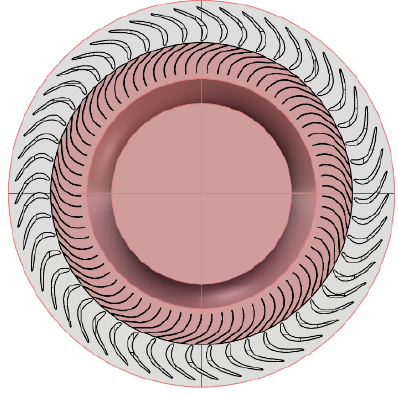
Figure 9. Optimised outflow rotor design. Table 3. Design characteristics of the optimised outflow turbine.